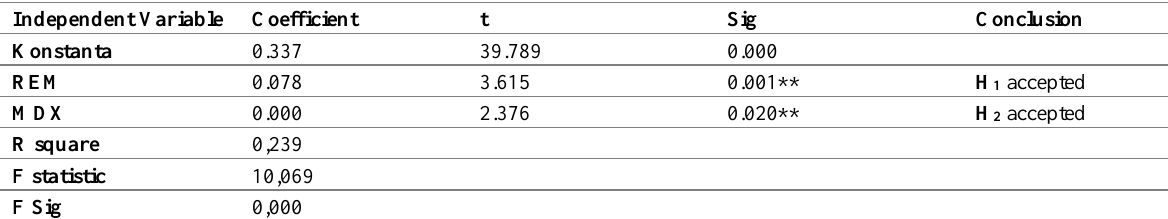
Table 3: Test Model 1 with Multiple Regression